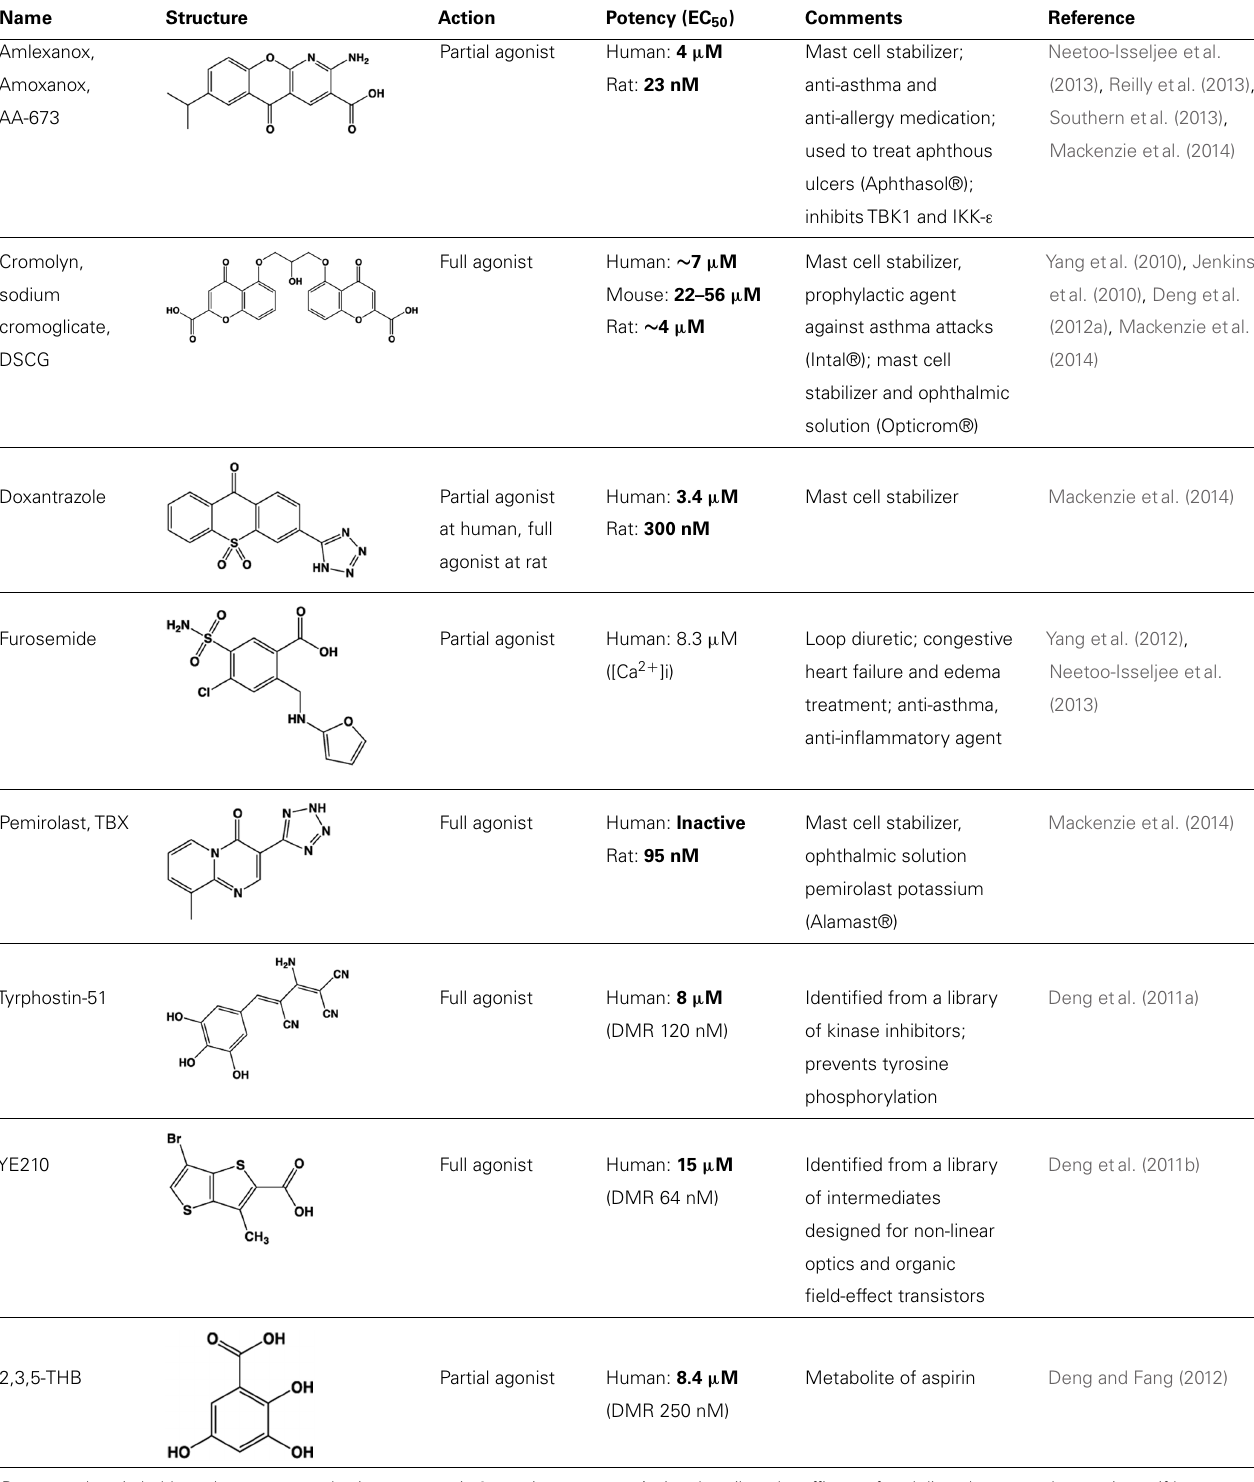
Table 3 | Selection of other synthetic GPR35